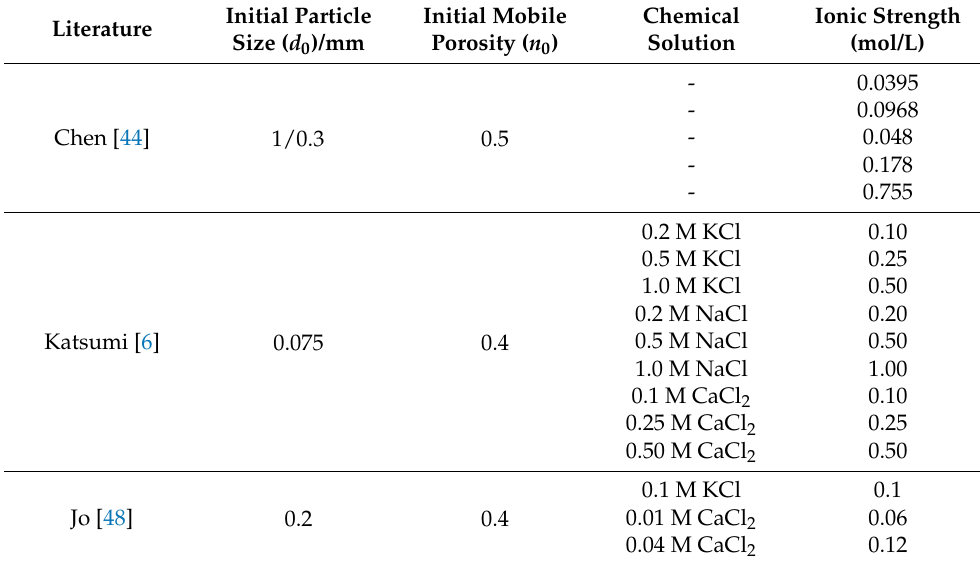
Table 4. Experimental parameter of verification.